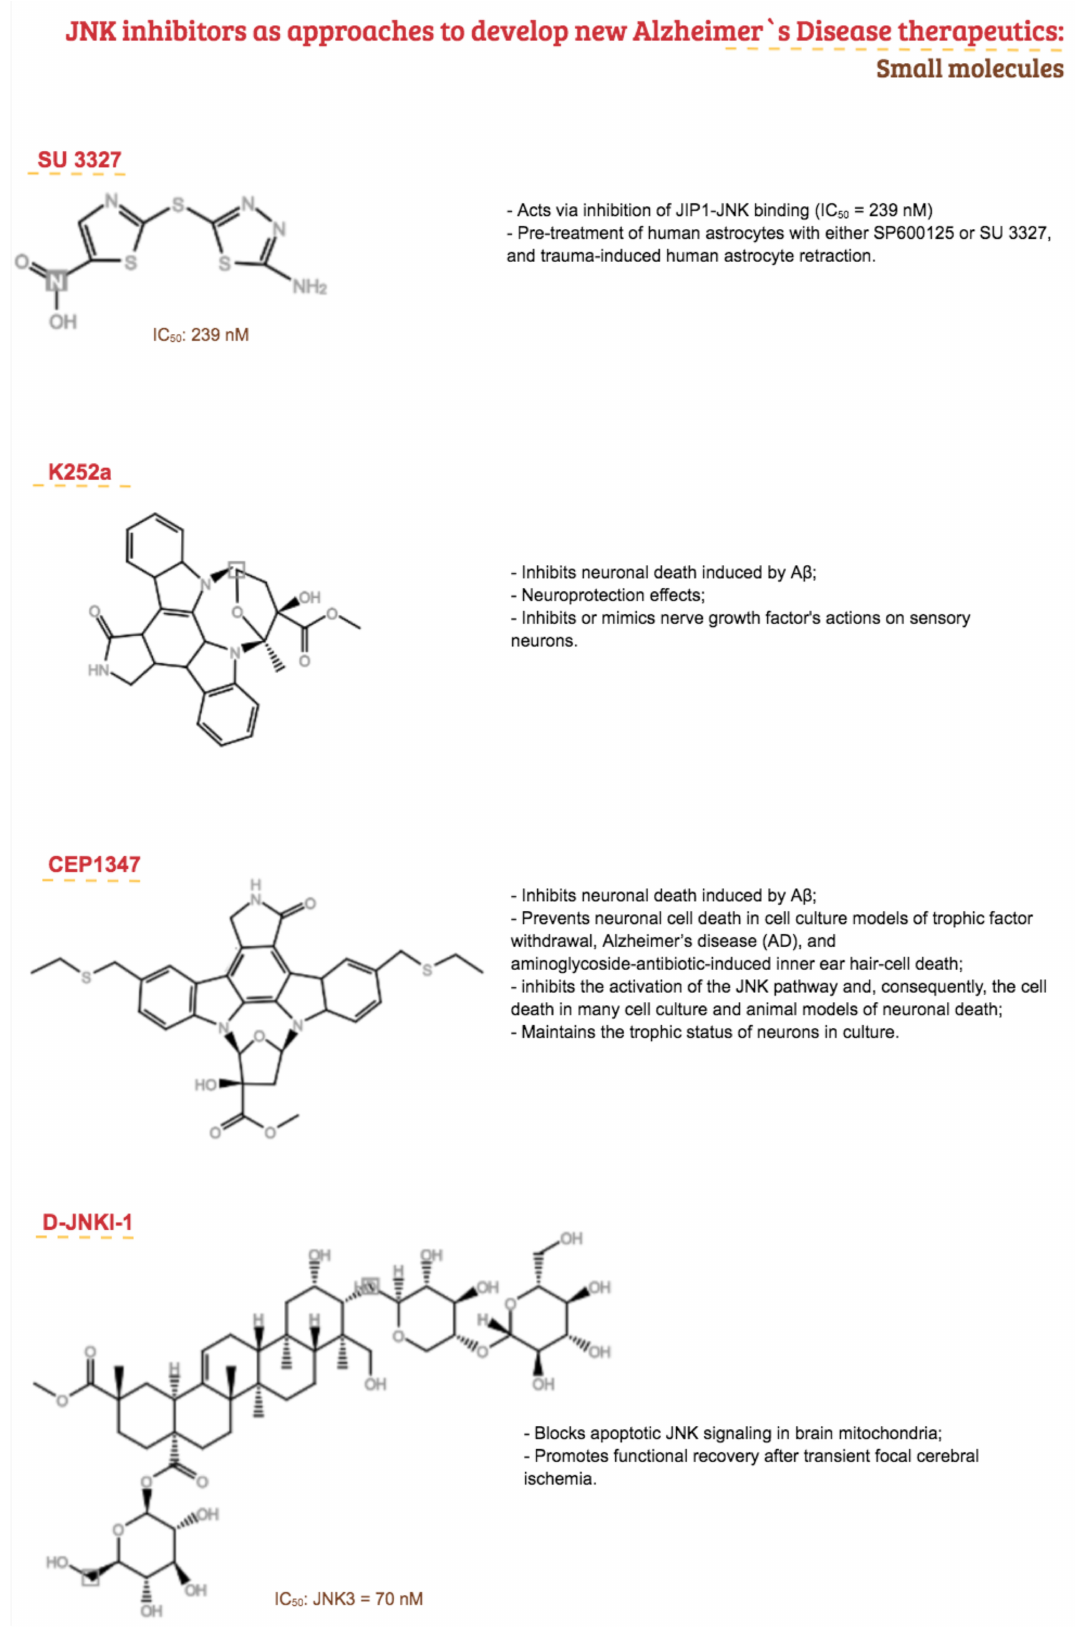
Figure 7. Summary of small molecules of JNK inhibitors used in neurological models that could be used as approaches to develop new Alzheimer’s disease (AD) therapeutics